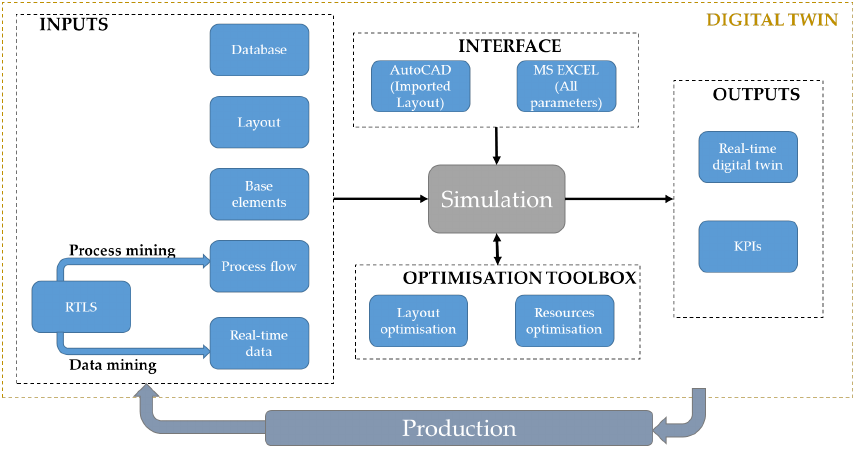
Figure 13. The scheme of the the open-station conveyor that is used to for wire-harness production.